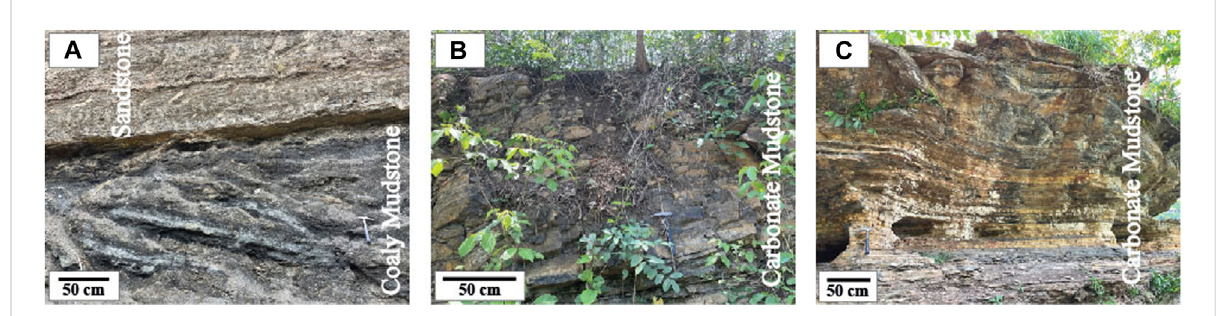
(Figure 1). The two outcrops belong to the Dat Fa Member based on the lithology description from Chonglakmani and Sattayarak